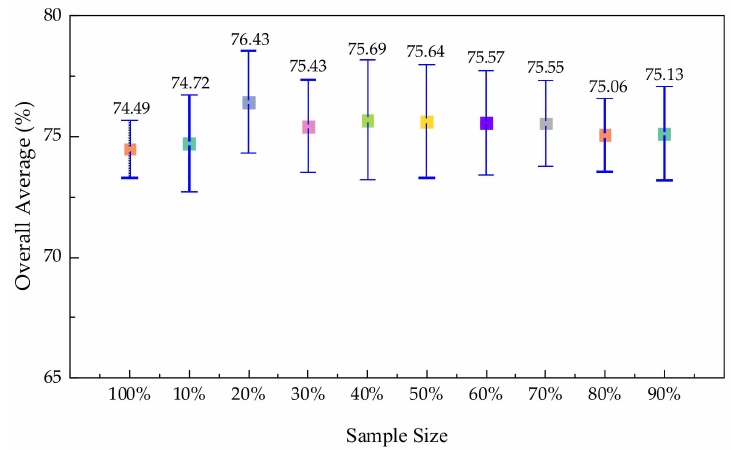
Figure 7. The overall accuracies and confidence intervals of SVM classifier after NKMNF with different proportion sample sizes (number of features = 45) in Indian Pines.